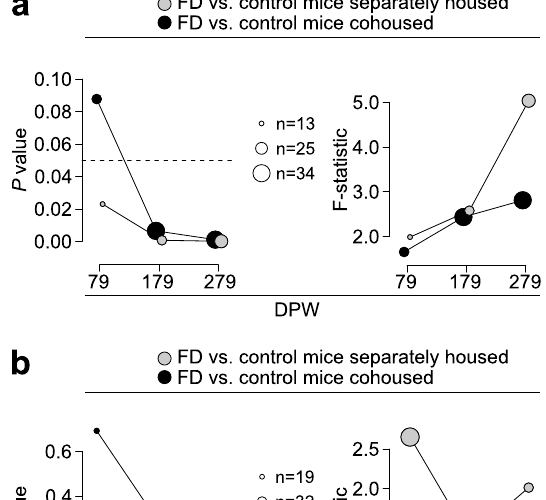
Fig. 4 | Cohousing ameliorates gut transit de fi cit and disease in FD mice. a , b Progressive changes in microbiome ( a ) and metabolome ( b ) diversity in FD mice compared to control mice when separately housed or cohoused (size of circles=number of mice sampled at each time; DPW=days post-weaning; dotted line represents p =0.05). c Pathology score of FD mice when housed separately or cohoused with control mice. d Carmine red-based gut transit for each mouse group. Groups in dotted box were cohoused. n = a , 79 DPW separately housed: 10 FD(4female,6male;3cages)vs.3control(female;1cage);79DPWcohoused:9FD (6 female, 3 male; 3 cages) vs. 12 control (7 female, 5 male; 3 cages); 179 DPW separatelyhoused:10FD(5female,5male;2cages)vs.11control(5female,6male; 3 cages); 179 DPW cohoused: 13 FD (6 female, 7 male; 4 cages) vs. 21 control (7 female, 14 male; 5 cages); 279 DPW separately housed: 13 FD (6 female, 7 male; 4 cages) vs. 21 control (7 female, 14 male; 5 cages); 279 DPW cohoused: 13 FD (7 female, 6 male; 4 cages) vs. 8 control (5 female, 3 male; 2 cages). b 79 DPW sepa- ratelyhoused:25FD(14female,11male;6cages)vs.29control(18female,11male;7 cages) mice; 79 DPW cohoused: 9 FD (6 female, 3 male; 3 cages) vs. 11 control (6 female, 5 male; 3 cages); 179 DPW separately housed: 10 FD (6 female, 4 male; 3 cages)vs.9control(7female,2male;3cages);179DPWcohoused:13FD(6female, 7 male; 4 cages) vs. 21 control (7 female, 14 male; 5 cages); 279 DPW separately housed: 15 FD (9 female, 6 male; 4 cages) vs. 12 control (5 female, 7 male; 3 cages); 279 DPW cohoused: 13 FD (6 female, 7 male; 4 cages) vs. 20 control (7 female, 13 male;5cages). c ,30 – 129DPW:86separatelyhoused(60female,26male;18cages) vs. 21 cohoused (13 female, 8 male; 5 cages); 130 – 229 DPW: 66 separately housed (47 female, 19 male; 14 cages) vs. 34 cohoused (13 female, 21 male; 8 cages); 230 – 329 DPW: 40 separately house (22 female, 18 male; 9 cages) vs. 34 cohoused (13female,21male;8cages); d ,15FD (12female,3male;3cages)and 11control(all female; 3 cages) mice separately housed; 9 FD (6 female, 3 male; 3 cages) and 10 control (7 female, 3 male; 3 cages) mice cohoused. PERMANOVA ( a , separately housed, day 79, df=1, R 2 =0.1528, day 179, df=1, R 2 =0.1193, day 279, df=1, R 2 =0.1941; cohoused, day 79, df=1, R 2 =0.0799; day 179, df=1, R 2 =0.0706; day 279,df=1,R 2 =0.0807; b ,separatelyhoused,day79,df=1,R 2 =,day179,df=1,R 2 =, day279,df=1,R 2 =;cohoused,day79,df=1,R 2 =;day179,df=1,R 2 =;day279,df=1, R 2 =); Welch ’ s two-sample t-testing with FDR correction ( c , DPW 30 – 129, t-statis- tic= − 2.7203, df=13.018, difference between FD cohoused and separately housed mice= − 1.8403, 95% con fi dence interval of difference between FD cohoused and separately housed mice= − 3.3015 to − 0.3790; DPW 130 – 229, t-statistic= − 4.1497, df=28.434, difference between FD cohoused and separately housed mice= − 2.1185, 95% con fi dence interval of difference between FD cohoused and sepa- rately housed mice= − 3.1635 to − 1.0735; DPW 230 – 329, t-statistic= − 3.7242, df= 20.515, difference between FD cohoused and separately housed mice= − 2.2170, 95%con fi denceintervalofdifferencebetweenFDcohousedandseparatelyhoused mice= − 3.4568 to − 0.9772; d , FD cohoused vs. separately housed, t-statistic= − 2.9745, df=18.025, difference between group means= − 1.1576, 95% con fi dence interval of difference between group means= − 1.9751 to − 0.3400; control cohoused vs. FD separately housed, t-statistic= − 4.6345, df=22.825, difference between group means= − 1.4317, 95% con fi dence interval of difference between group means= − 2.0710 to − 0.7923; control separately housed vs. FD separately housed, t-statistic= − 3.5146, df=23.385, difference between group means= − 1.0759, 95% con fi dence interval of difference between group means= − 1.7087 to −